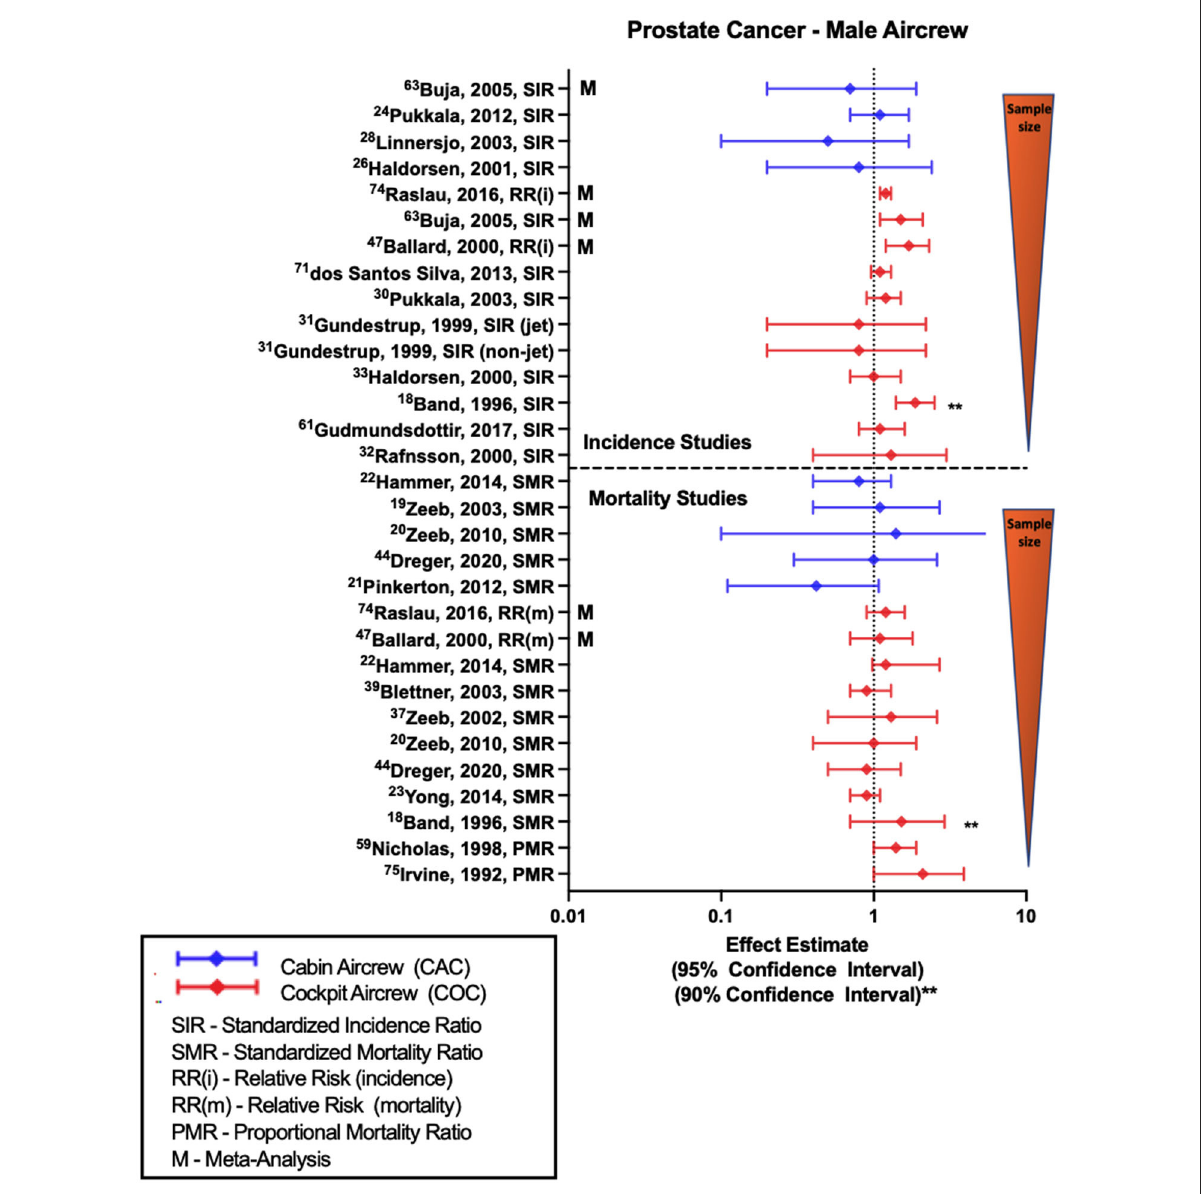
FIGURE4 Forest plot for studies evaluating prostate cancer incidence or mortality ratios among male aircrew in association to CIR